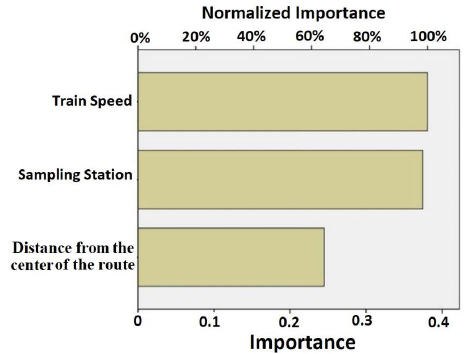
Figure 4: The importance of each of the effective factors in